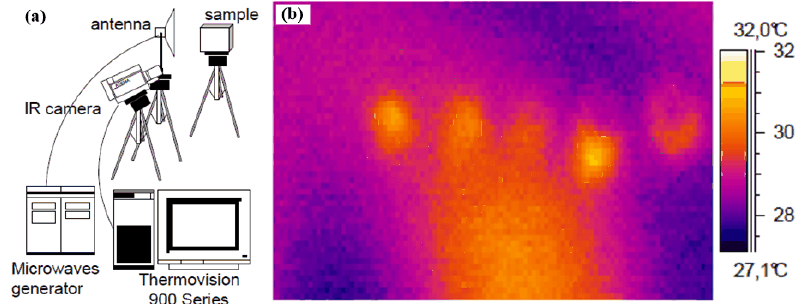
Figure 20. MWT setup at the Military Institute of Armament Technology ( a ) and results for water in the honeycomb material ( b ) [72].